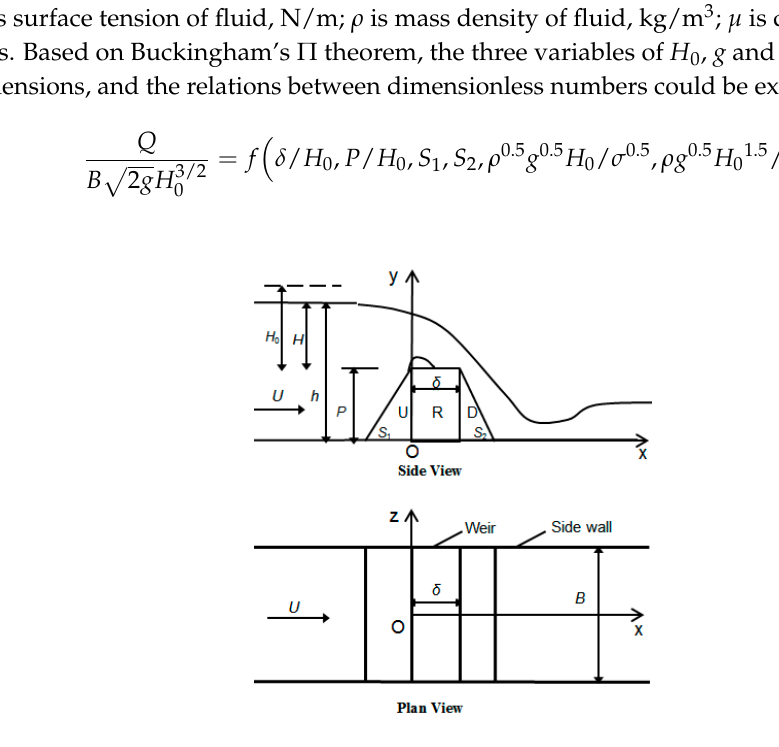
Figure 1. Definition sketch of free overflow over rectangular short-crested weir with sloped weir faces. The left term represents the fundamental weir formulae (Equation (3)) where m is the discharge coefficient.